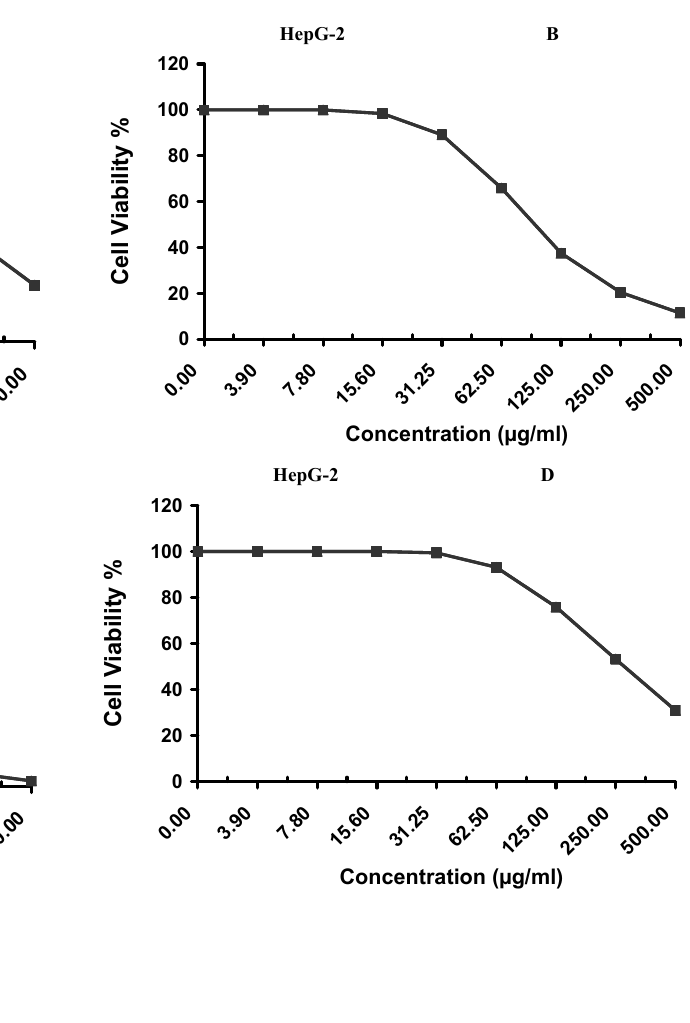
different doses of the test samples. ( A ) the unloaded PLGA NPs, ( B ) the PLGA-Cf-F 1 NPs, ( C ) the